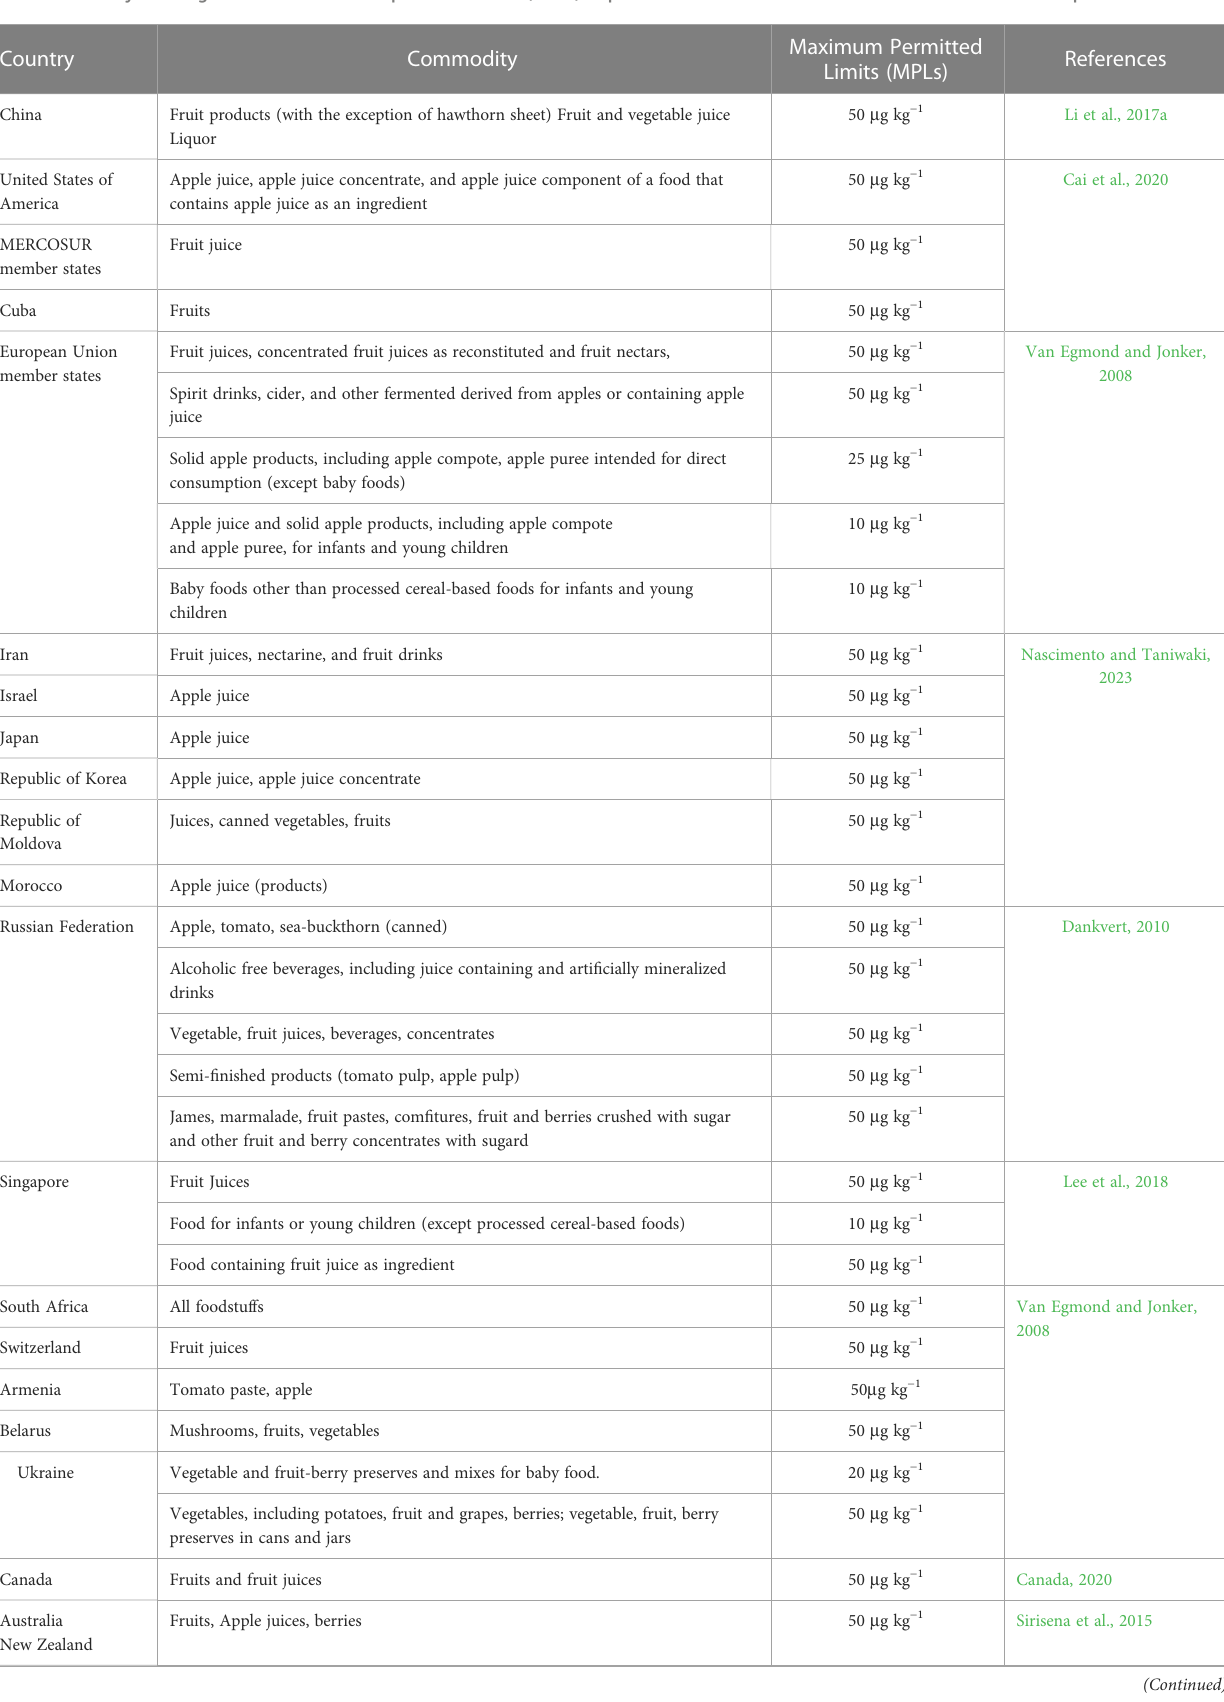
TABLE 7 Country wise regulations on Maximum permitted limits (MPLs) of patulin and Alternaria content in fruits and their derived